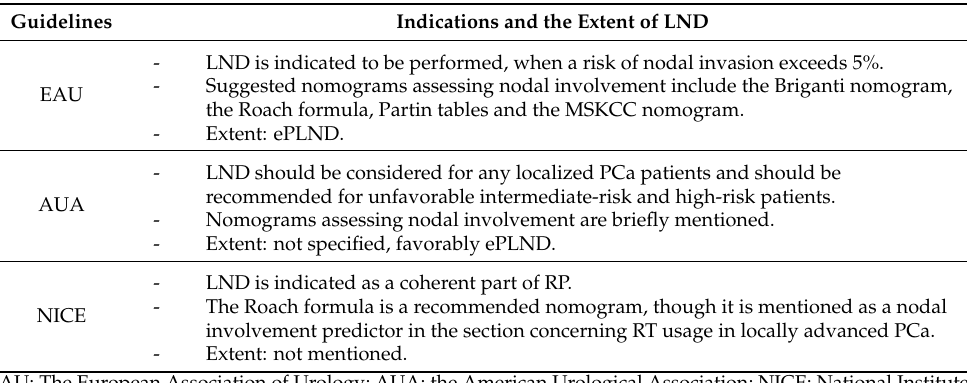
Table 1. Overview of indications and extents of LND in PCa according to guidelines provided by the EAU, the AUA, and the